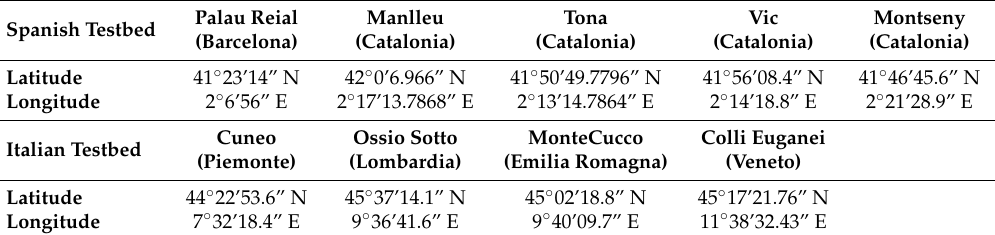
Table 1. Reference Stations geolocalization.